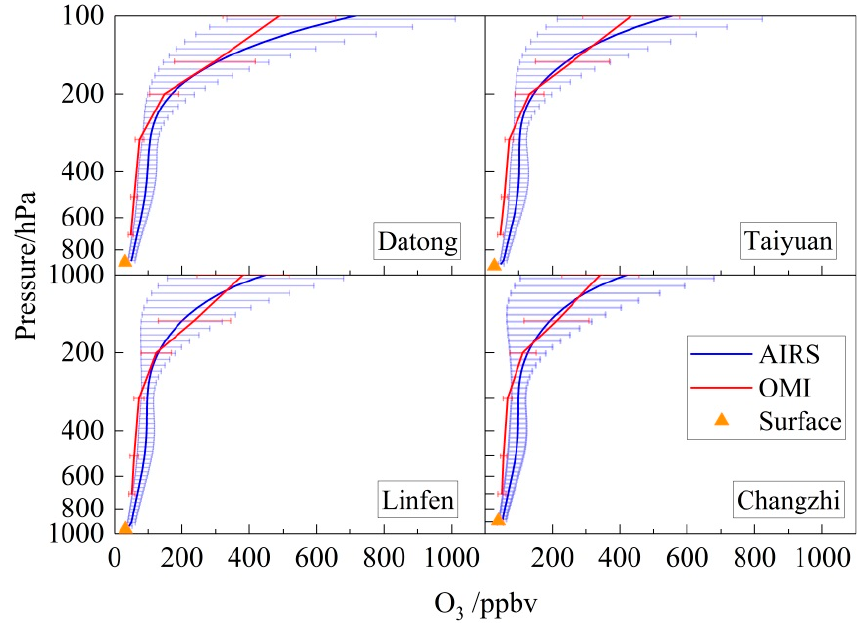
Figure 14. Comparison of annual mean O 3 vertical profiles from AIRS (blue line) and OMI (red line) over Datong, Taiyuan, Linfen and Changzhi. The solid lines represent annual mean O 3 volume mixing ratio (VMR), and the error bars plot the standard deviation. The solid triangles show annual mean surface O 3 VMR.